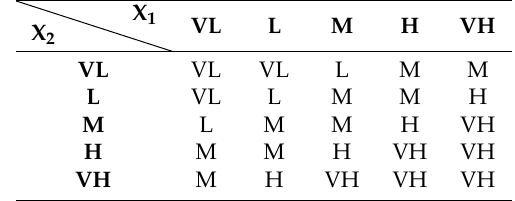
Table 3 indicates the fuzzy logic rules based on the maximum rule-based method for water supply